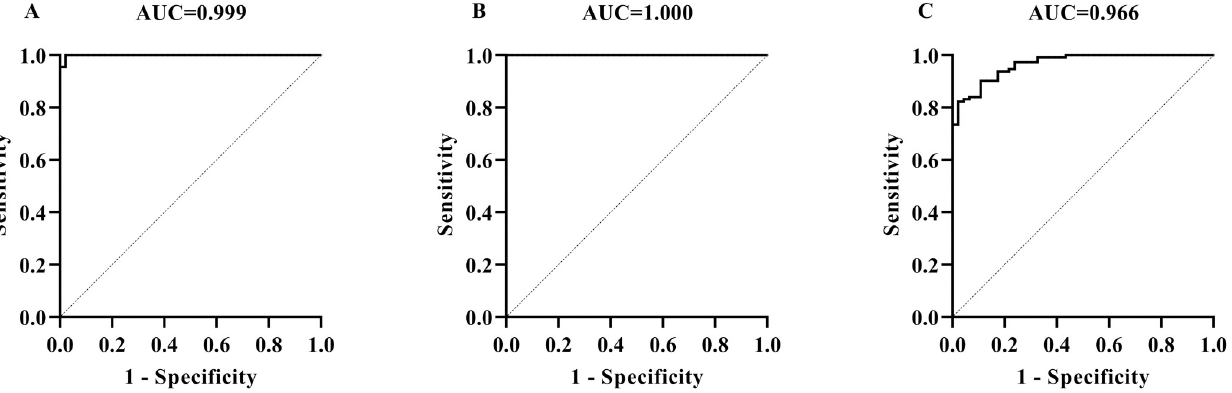
Fig 3. Determination of cut-off values, diagnostic sensitivities, and specificities of MMEC/AG-iELISA for sheep TB caused by M . bovis infection by using the maximum AUC. The ROC curves of MMEC/AG-iELISA for detecting antibodies in serum samples at dilutions of 1:25 (A), 1:50 (B), and 1:100